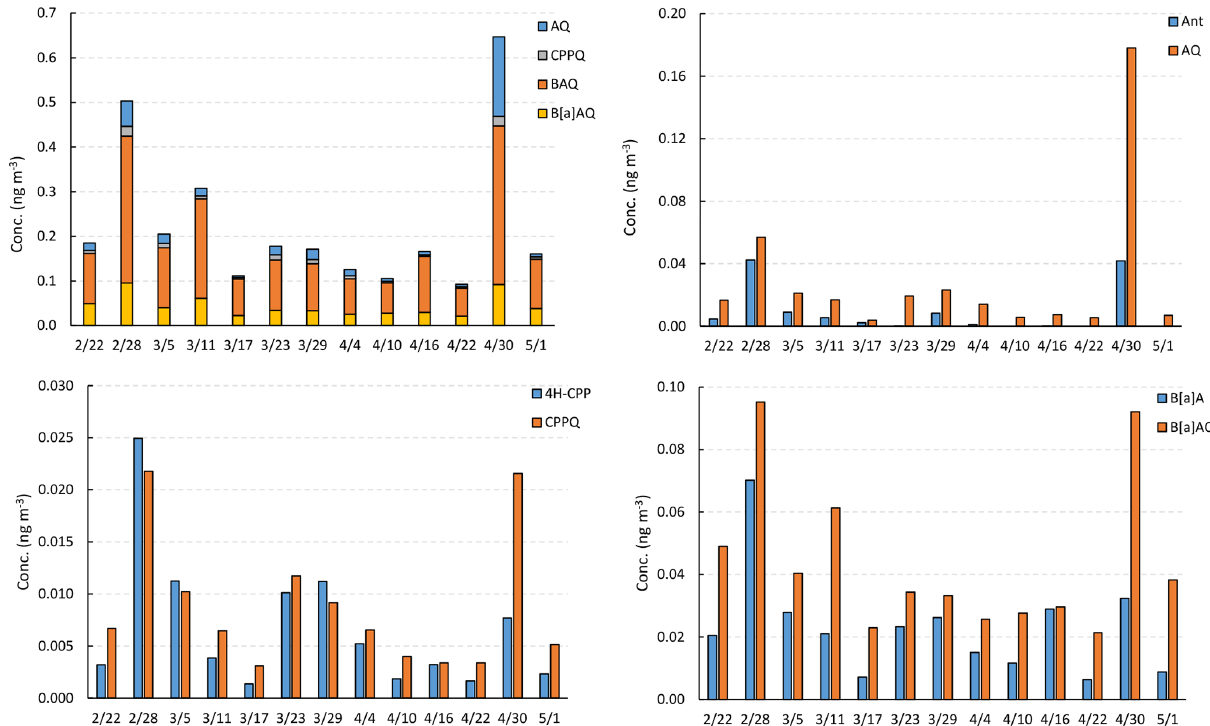
Figure 7. Measured concentration of total OPAHs (AQ, CPPQ, BAQ and B[a]AQ) and individual concentration of OPAH and its parent PAH in PM 10 collected from Stockholm urban background (TK) during 22 February–5 May